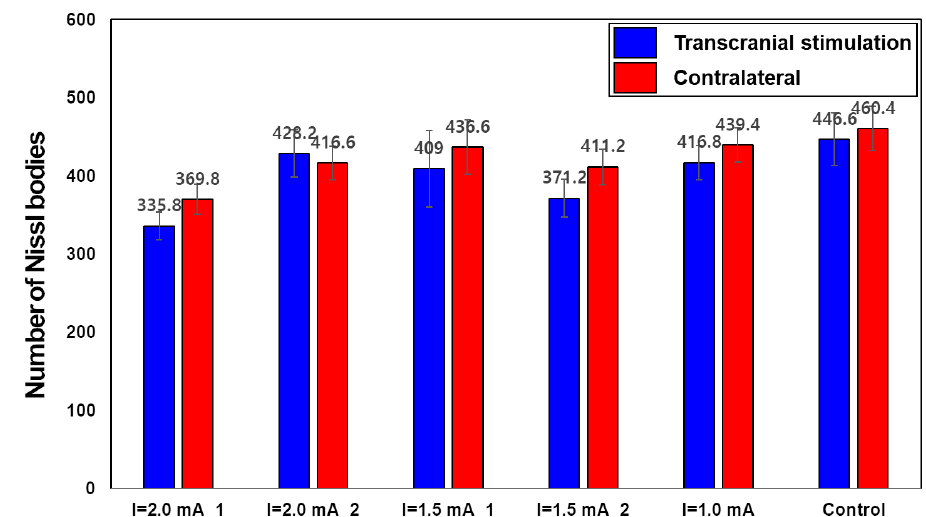
Figure 5. Quantitative comparison of the numbers of Nissl bodies (neuronal components) in sub- images of Cresyl violet-stained brain slide scan images. Although there was a difference in the number of Nissl bodies between the two regions in all the experimental cases, including the control (no current), the deviation was approximately 10%, indicating that there was no significant reduction in neuronal components due to brain damage.